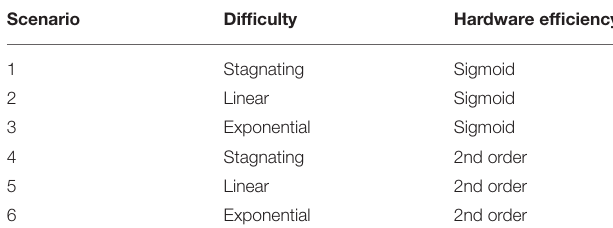
TABLE 2 | Block difficulty and hardware efficiency combination for each scenario for the Bitcoin network.